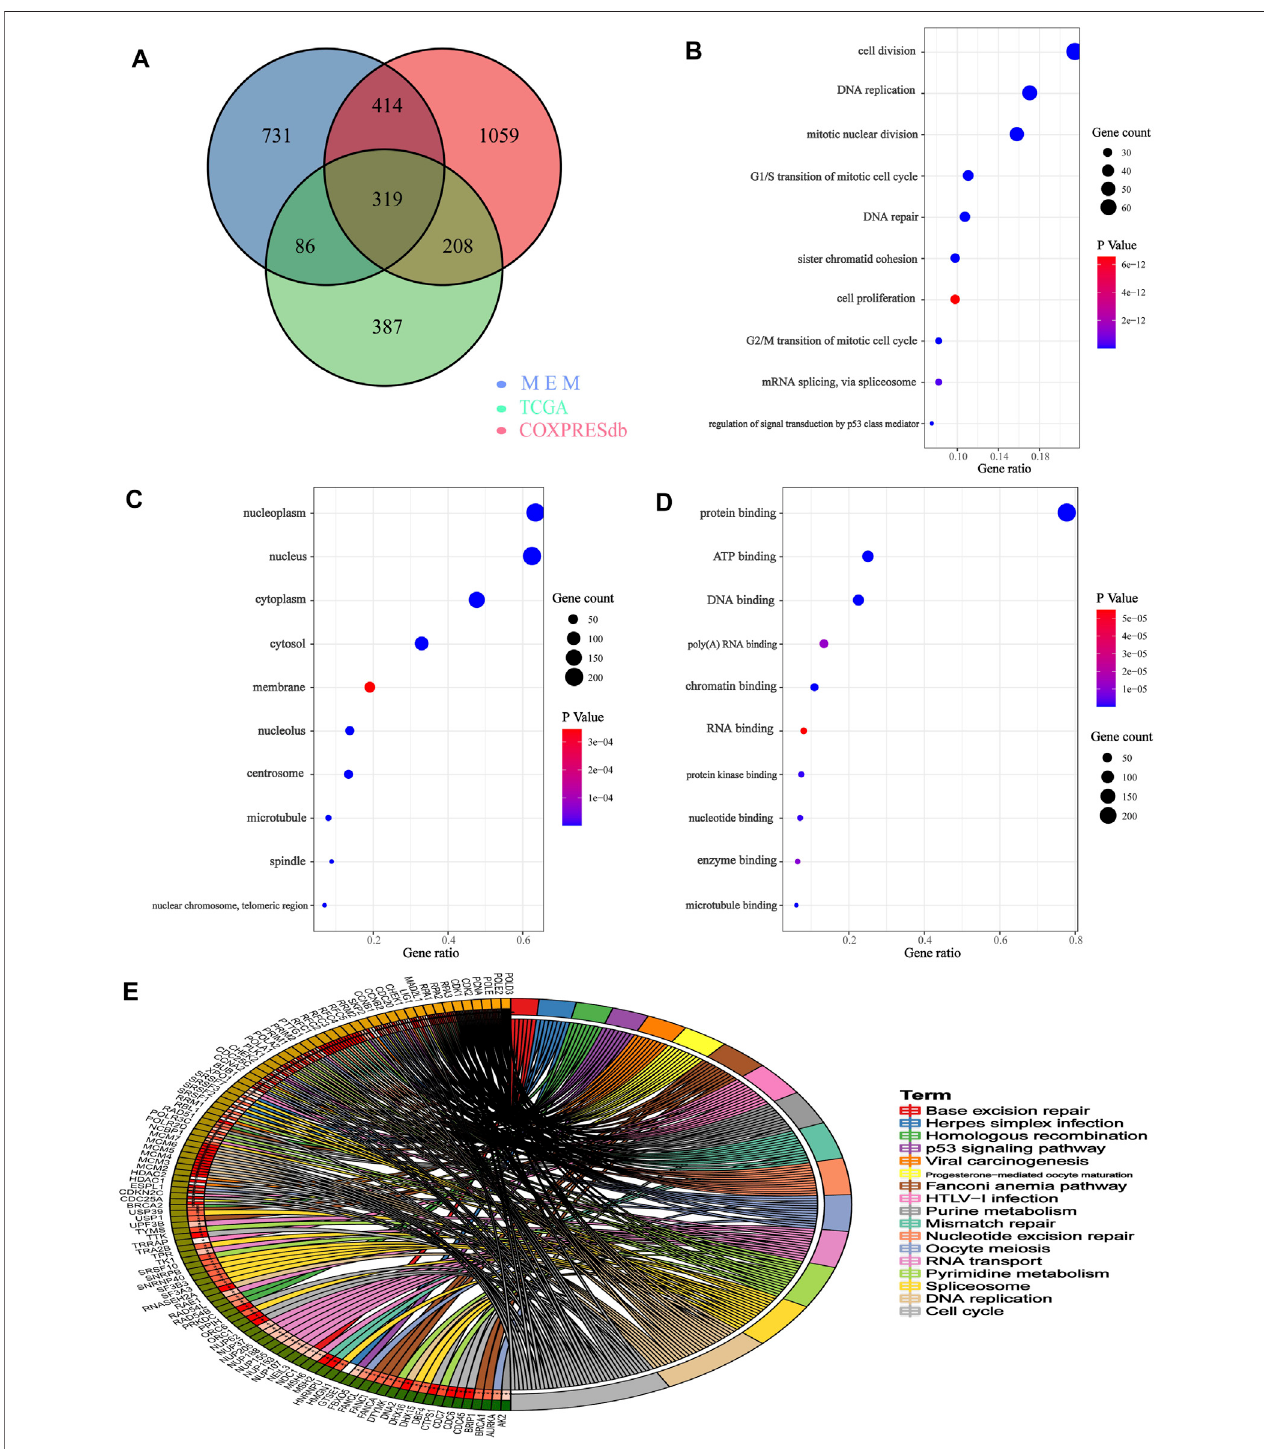
FIGURE5| Functional enrichmentofC1ORF112 and its co-expressedgenesinlow-gradegliomas. (A) Venndiagram of C1ORF112 co-expressed genesin LGG. (B) Enriched GO terms in the “ biological process ” category. (C) Enriched GO terms in the “ cellular component ” category. (D) Enriched GO terms in the “ molecular function ” category. (E) Kyoto Encyclopedia of Genes and Genomes Pathway.